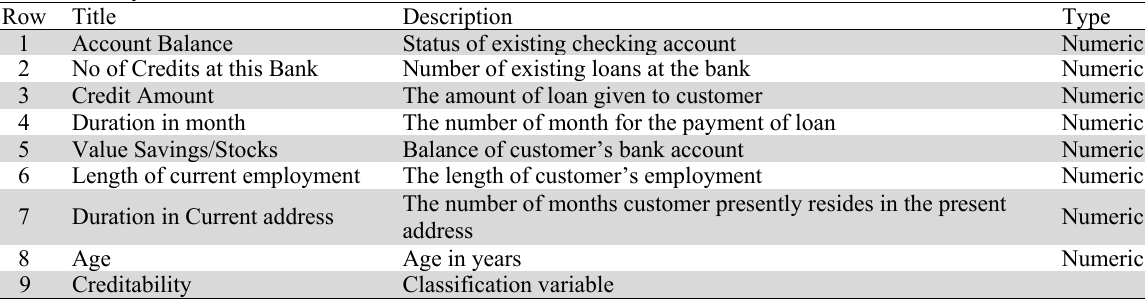
The summary of the statistical observations